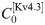
State transition diagram of the Markov model for the Kv4.3 channel.
C0[Kv4.3]–C4[Kv4.3] are the closed states; O[Kv4.3] is the open state and I0[Kv4.3]–I6[Kv4.3] are the inactivation states; α[Kv4.3], β[Kv4.3], kci[Kv4.3], kic[Kv4.3], koc[Kv4.3], kco[Kv4.3], k56[Kv4.3] and k65[Kv4.3] denote transition rates between the states.